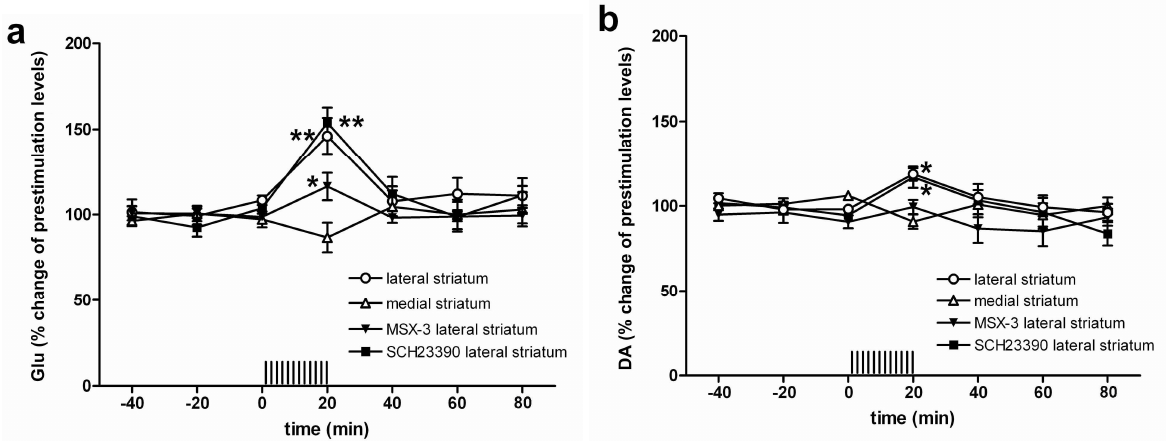
FIGURE 7. A 2A receptor antagonist–induced blockade of striatal glutamate release induced by cortical electrical stimulation. Extracellular levels of glutamate (a) and dopamine (b) in the striatum after cortical electrical stimulation. Cortical stimulation in the orofacial area of the motor cortex produced a significant increase in the extracellular concentrations of glutamate (Glu) and dopamine (DA) in the lateral, but not the medial, striatum. Perfusion of the A 2A receptor antagonist MSX-3, but not the D 1 receptor antagonist SCH23390, significantly counteracted the increase in glutamate and dopamine extracellular levels in the lateral striatum induced by cortical electrical stimulation (repeated measures ANOVA: p < 0.05). Results represent means ± SEM of percentage of the mean of the three values before the stimulation; n = 5–10 per group. Time ‘0’ represents the values of the samples previous to the stimulation. The train of vertical lines represents the period of cortical stimulation. *, **: significantly different ( p < 0.05 and p < 0.01, respectively; Newman-Keuls posthoc tests) compared to value of the last sample before the